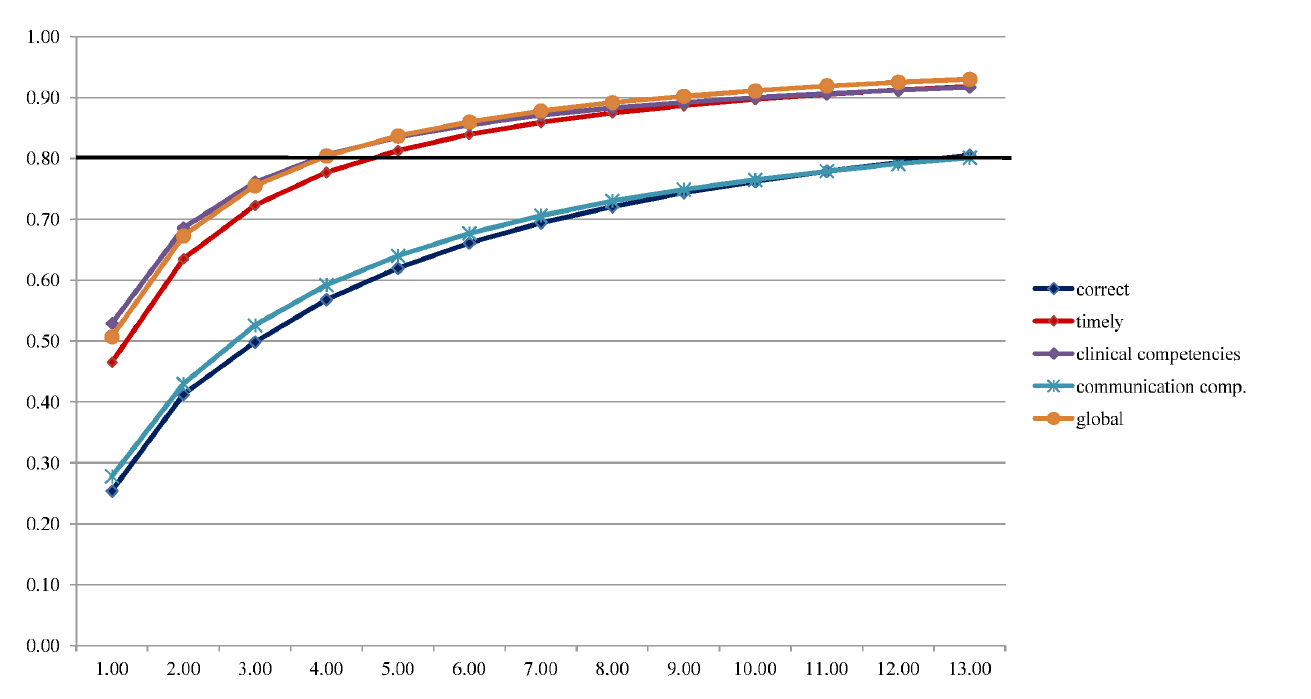
Fig. 1. Absolute G-coefficients as a function of number of raters per assessment format.